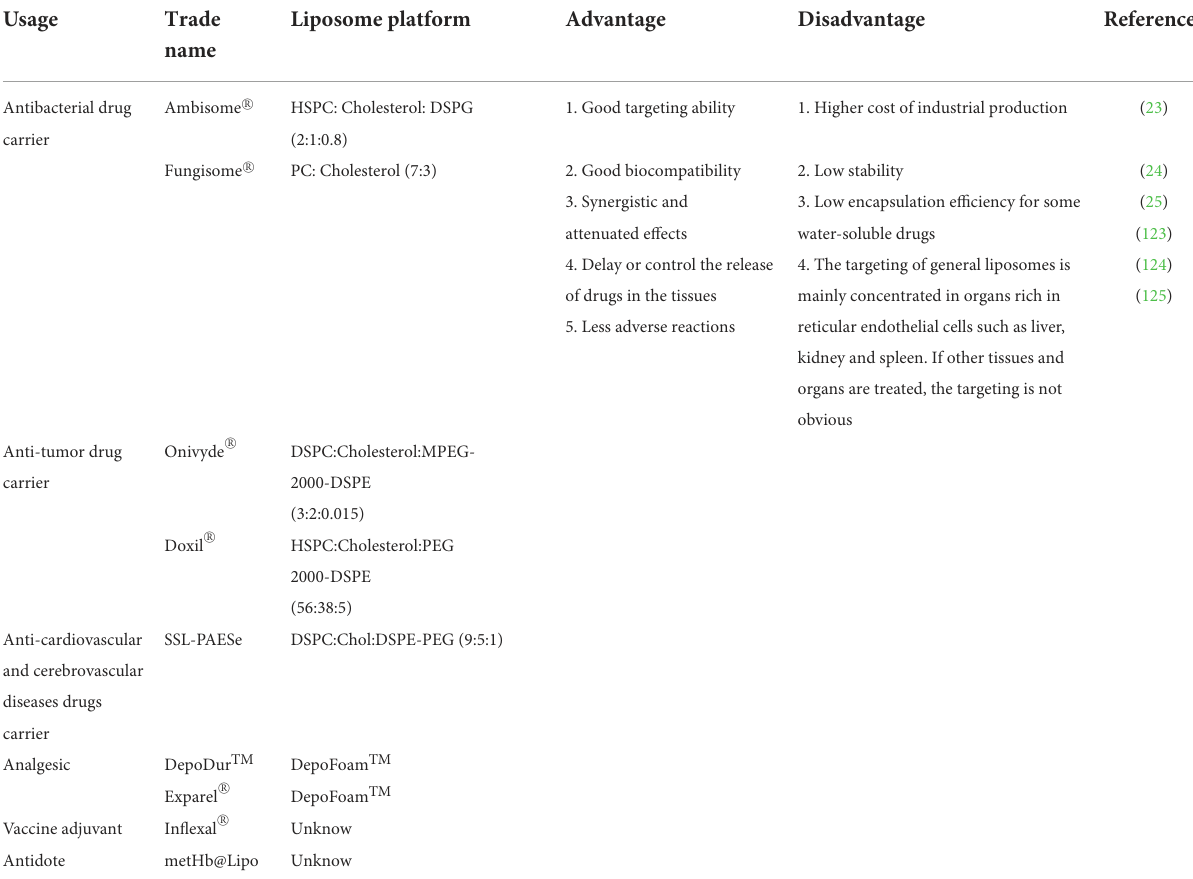
TABLE 1 Application and characterization of liposomes.